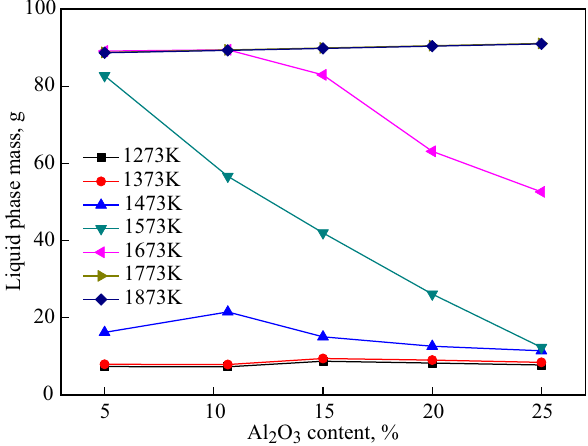
Figure 14: Relationship between liquid production and Al 2 O 3 content at di ff erent